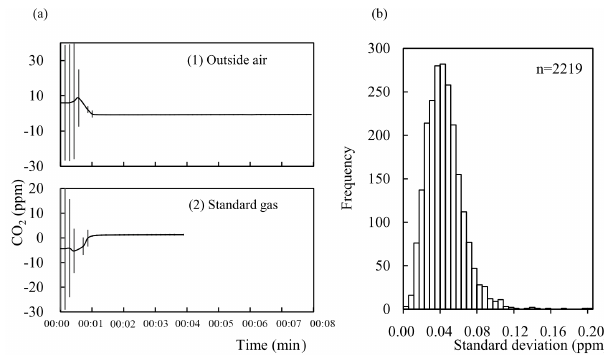
Figure 3. (a) The difference in CO 2 concentration for (1) outside air and (2) standard gas, between the individual measurement values (averaged for 10s) and over the entire measurement periods, and (b) standard deviation of standard gas measurement values during